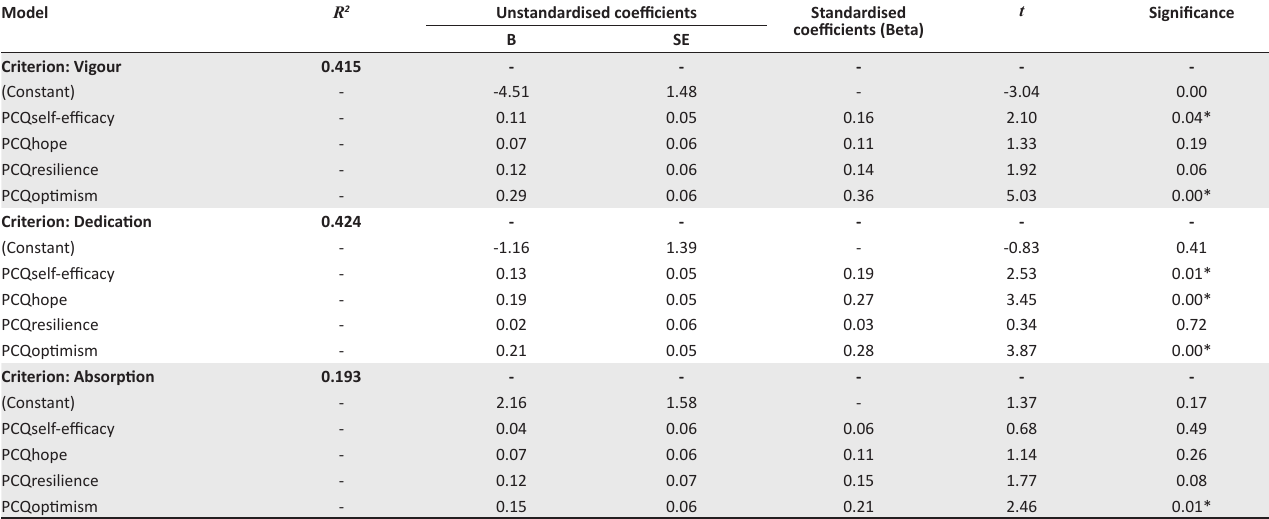
TABLE 3: Regression analysis of the Psychological Capital sub-dimensions on the three work engagement sub-dimensions. Model R